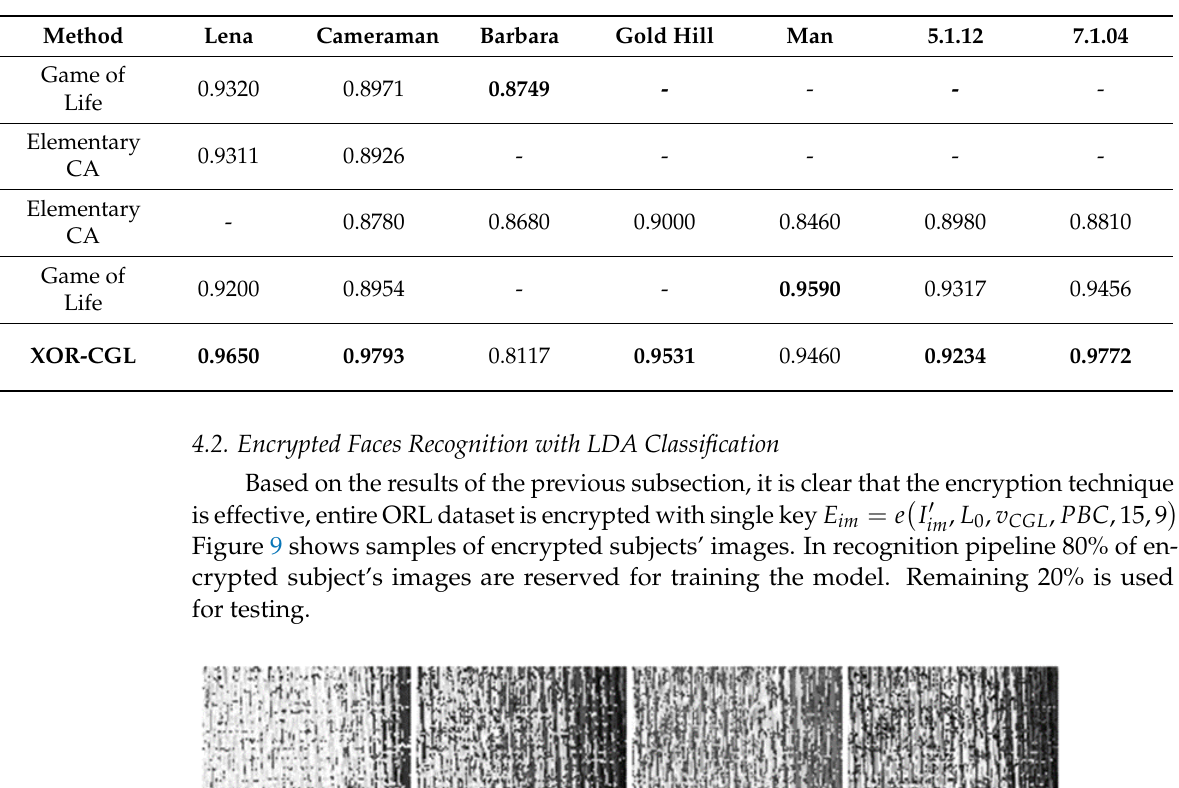
Table 7. Comparing different CA based scrambling techniques GDDs.